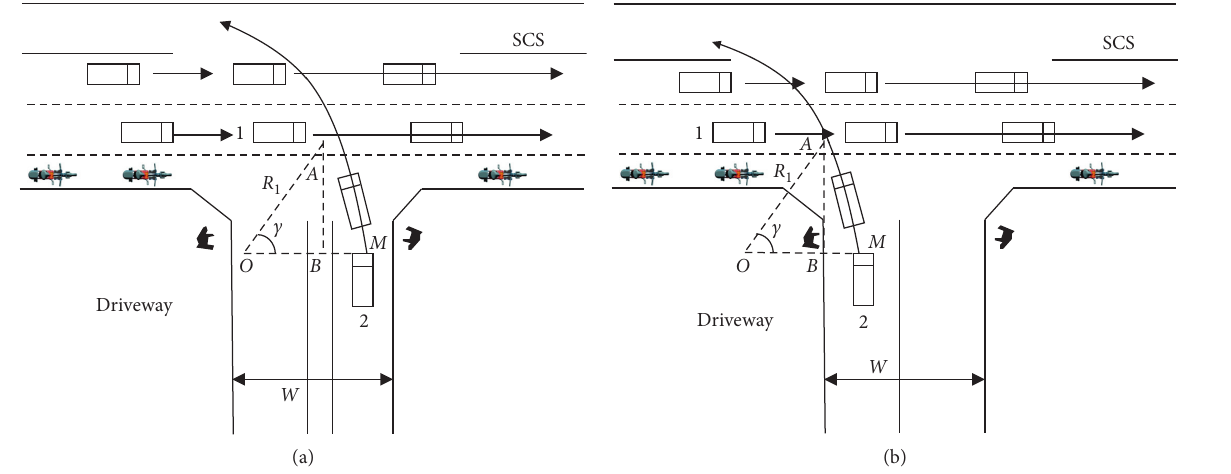
Figure 4: Left-turning on two-way SCS. (a) Right-side left-turning. (b) Left-side left-turning.